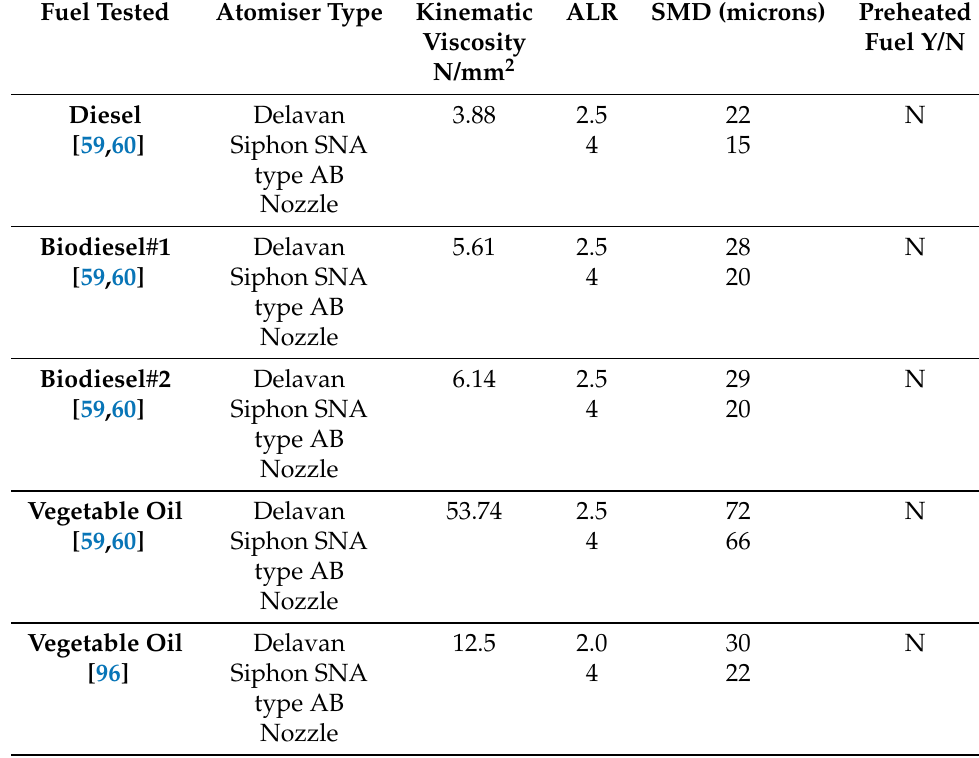
Table 4. Spray atomisation tests and observations carried out in simulated GT combustor using vari- ous biofuels and